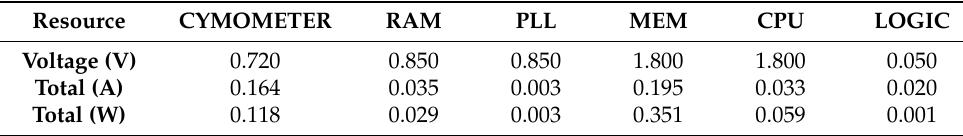
Table 5. Performance comparison.